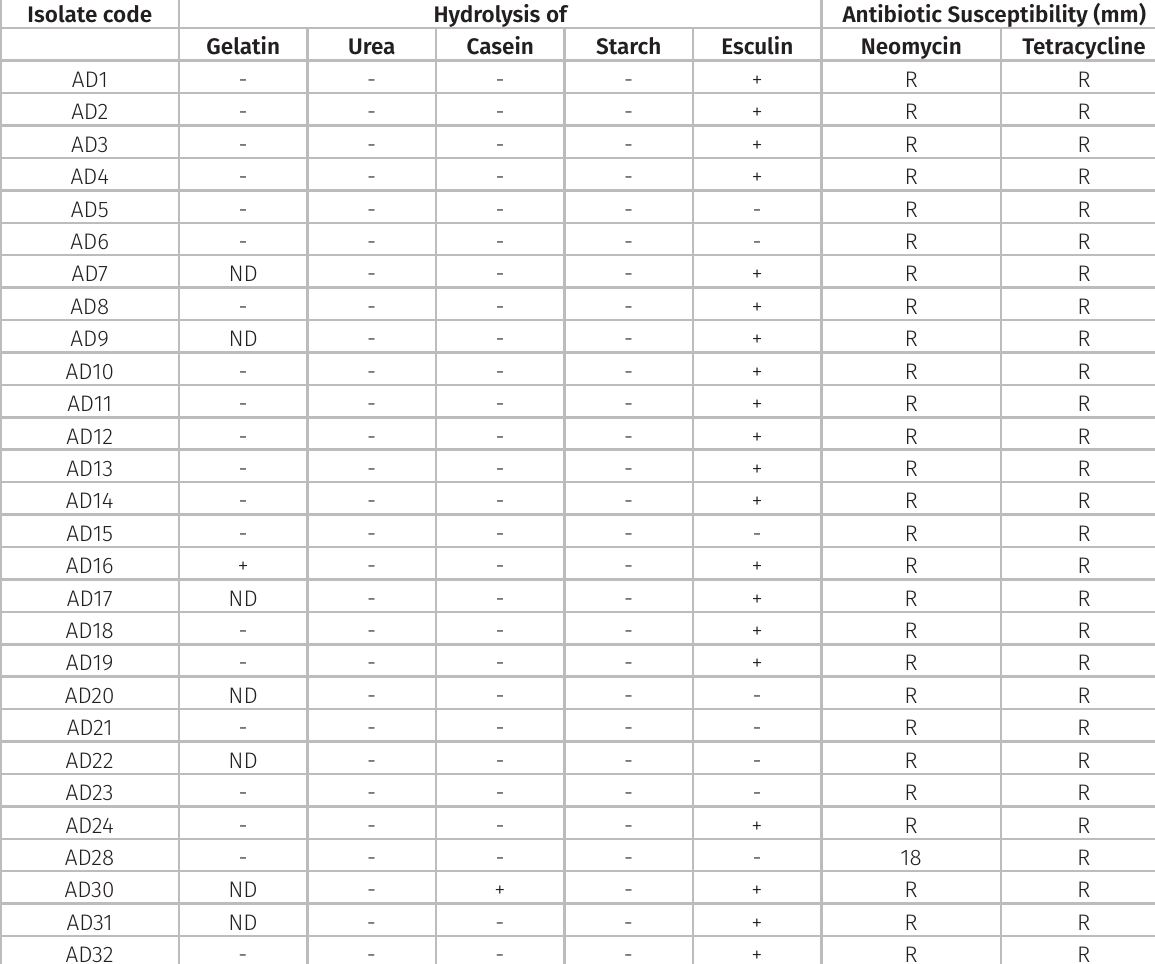
Table II. Phenotypic characteristics (hydrolysis of various substrates and antibiotic susceptibility) of the isolates. Isolate